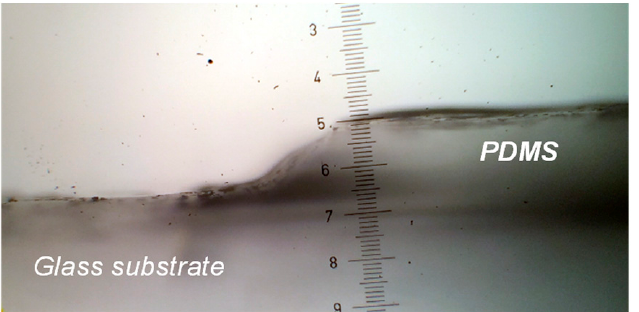
Figure 2. Topological photopatterning of silicon membranes, via irradiation and solvent wash of un-crosslinked zones (left side). The superimposed ruler gives an idea of the dimensions of the gradual transition from the obtained PDMS film to the naked glass substrate after washing, typically 2 cm wide.